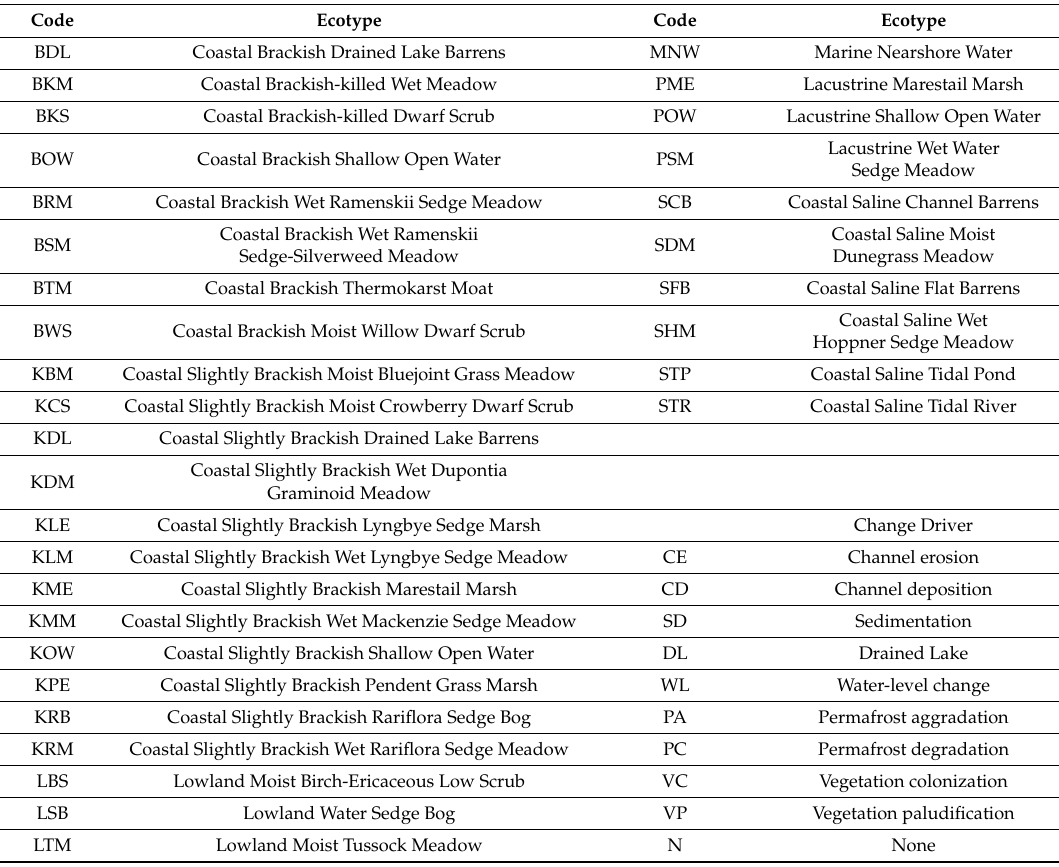
Table 1. List of ecotypes and change